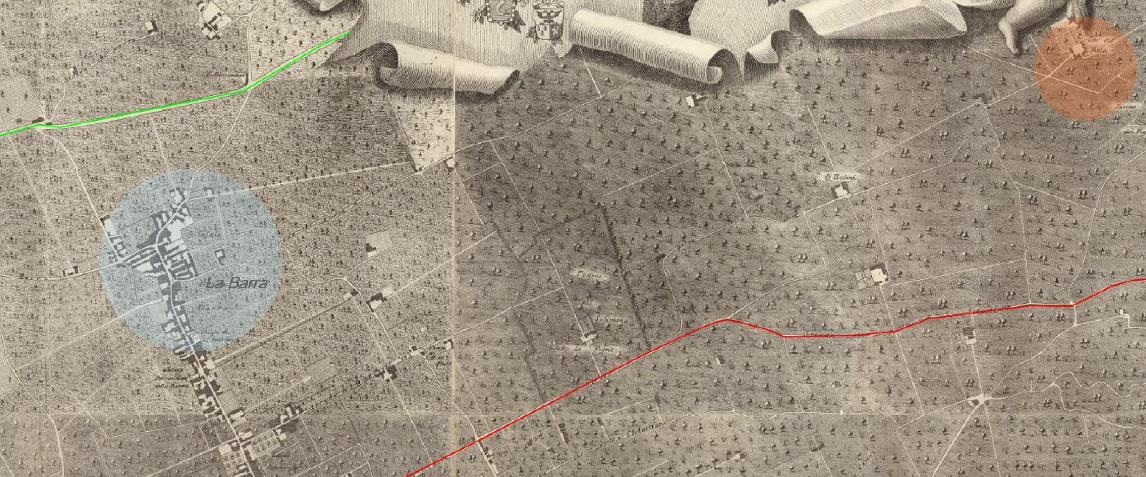
Figure 3. Mappa topografica della città di Napoli e de’ suoi contorni di Giovanni Carafa duca di Noja e Niccolò Carletti, published in the1775, details of paper 14.